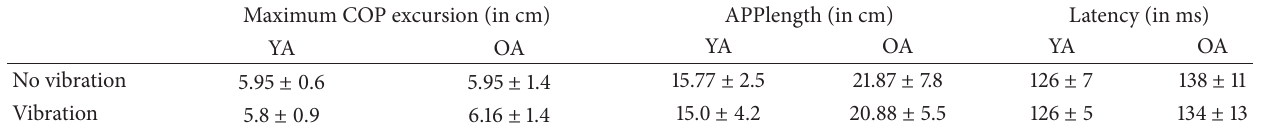
Table 2: Summary of results from experiment 3. YA: younger adults, OA: older adults ( 𝑛 = 20 ). Maximum COP excursion (in cm)